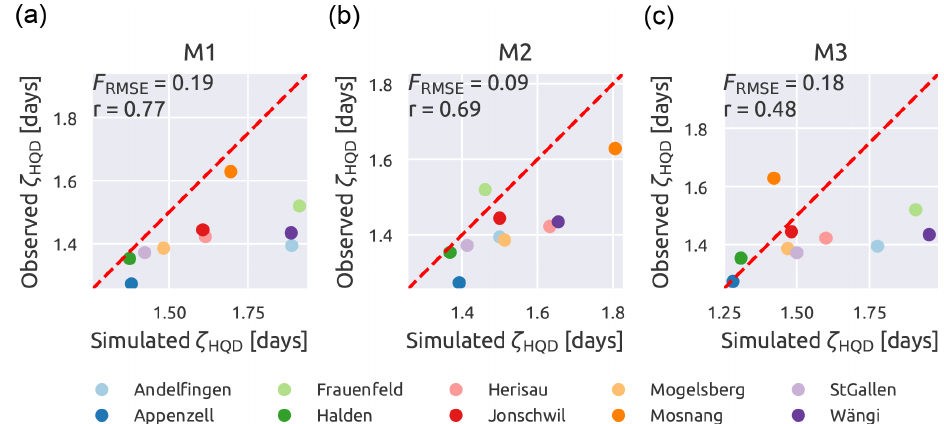
Figure 10. Ability of the hydrological models to represent the signature duration of low-flow events ( ζ HQD ). Single-HRU model (a) , two- HRU model based on geology (b) , and two-HRU model based on land use (c)